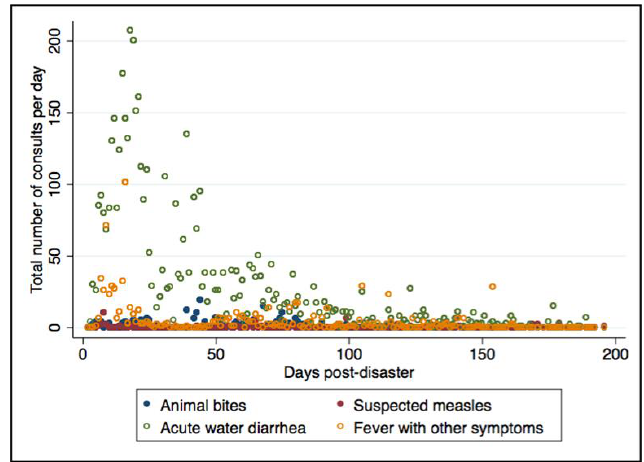
Figure 3. Total daily consultations of the most common immediately notifiable syndromes (animal bites and suspected measles) and the most common weekly notifiable syndromes (acute watery diarrhea and fever with other symptoms) across time among all reporting health facilities.